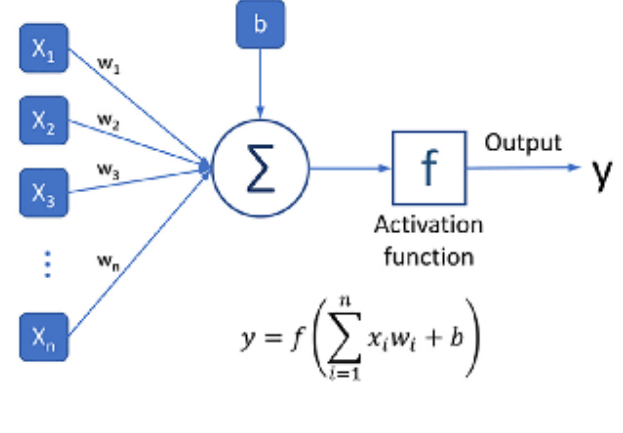
Figure 1. Basic concepts of artificial neural